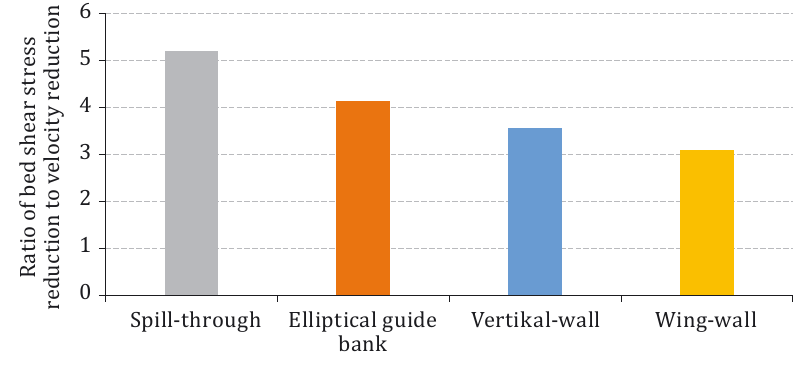
Spill-through Elliptical guide Vertikal-wall bank Figure 16. Diagrams of the ratio of bed shear stress reduction to velocity reduction in the flow-guiding embankment in different cases